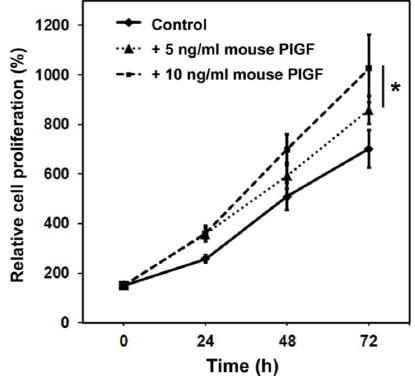
Figure 1. Murine placental growth factor (PlGF) enhances the proliferation of human PC-3 prostate cancer cells. PC-3 cells were incubated with 5 and 10 ng/mL recombinant mouse PlGF. Cell proliferation, measured by WST-1 cell proliferation assays after 24, 48 and 72 h was enhanced in a time-dependent manner. Proliferation was expressed as percentage of corresponding untreated control cells on day 0 (mean ± SD). * cells treated with 5 and 10 ng/mL PlGF were significantly different from control, p <